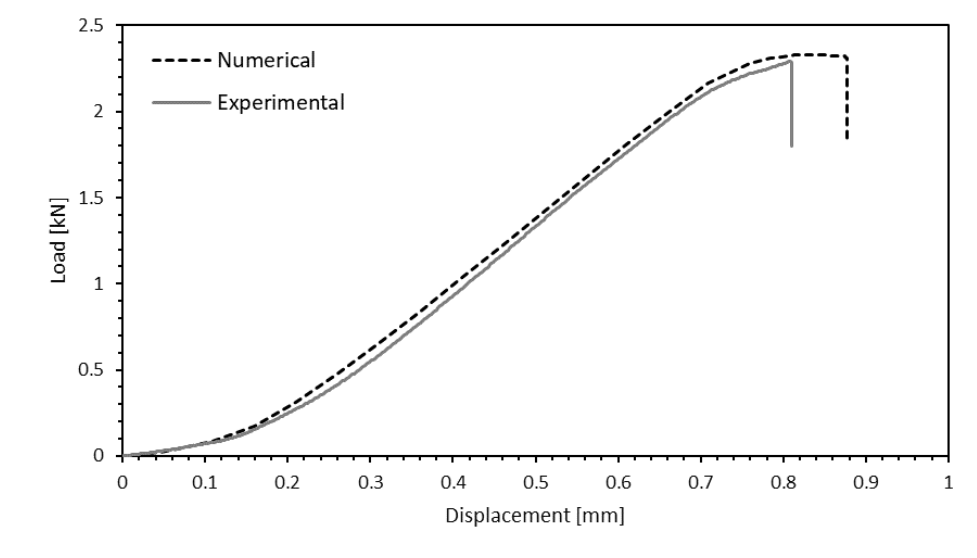
Figure 27. Comparison between numerical and experimental load-displacement curves.